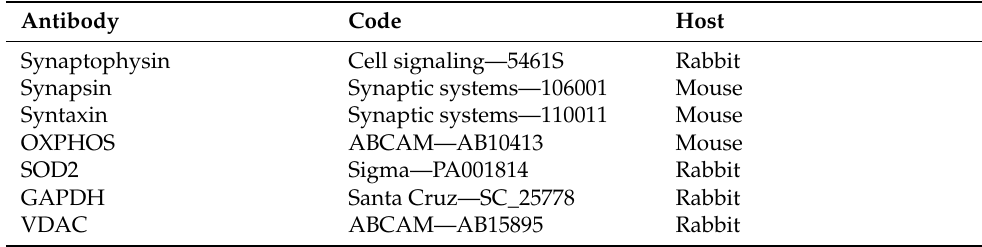
Table 2. List of primary